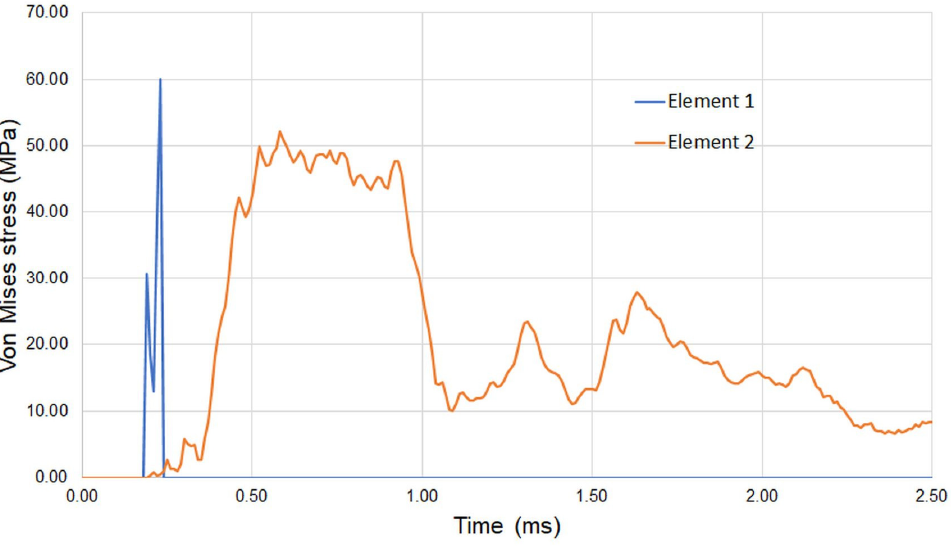
Figure 33. Distributions of Von Mises stresses of two elements: 1—the central element; 2—element located 0.1 m from the center.